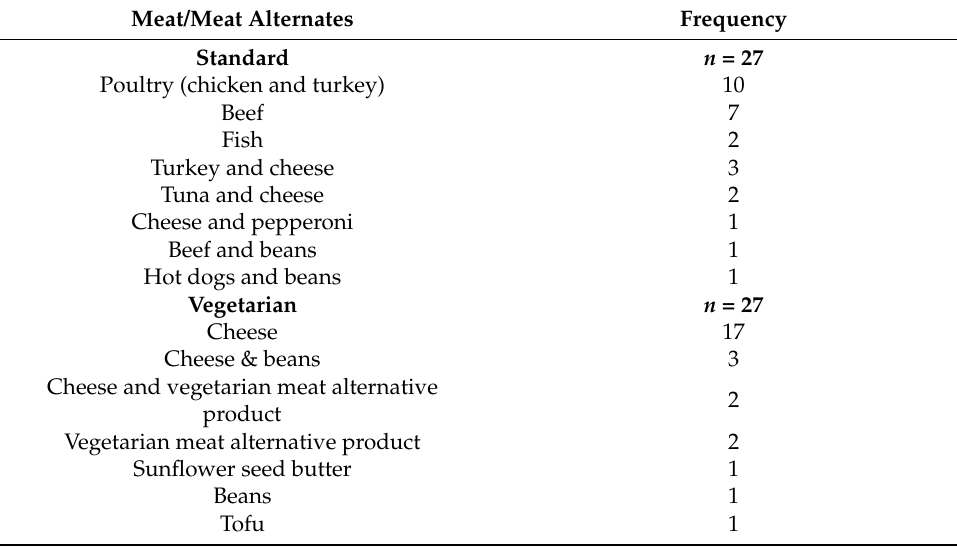
Table 1. Frequency of meat/meat alternates served across 54 total